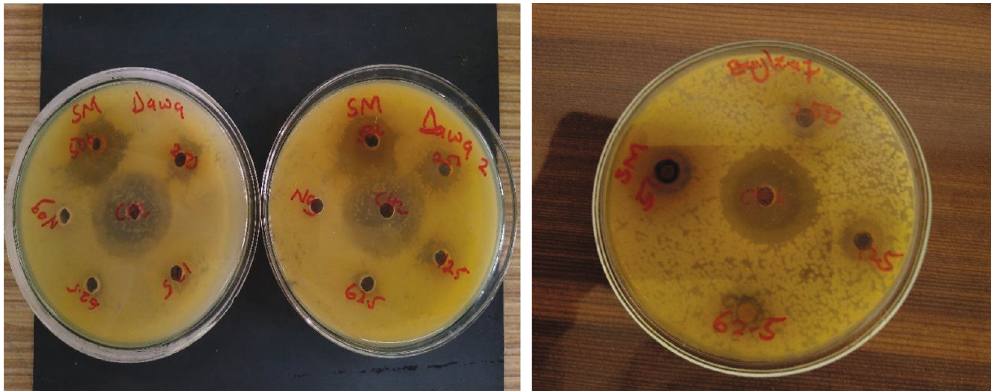
Figure 4: Zone of inhibition exhibited by (a) dawadawa and (b) bay leaf extracts against Streptococcus mutans